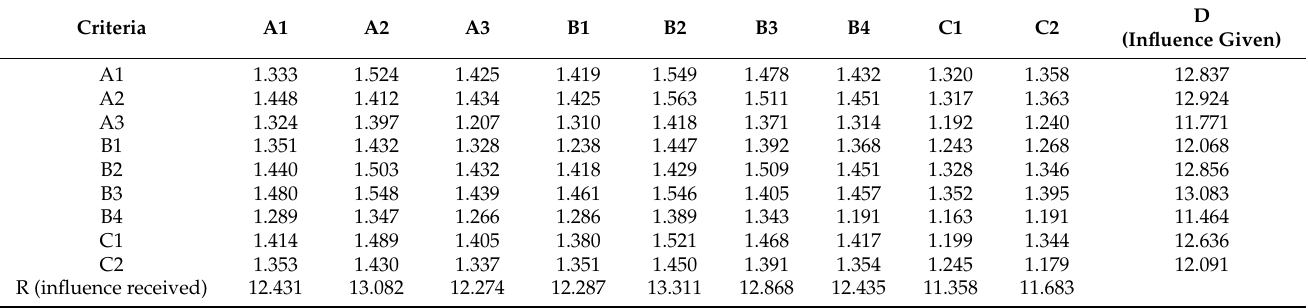
Table 3. Total Influence Matrix